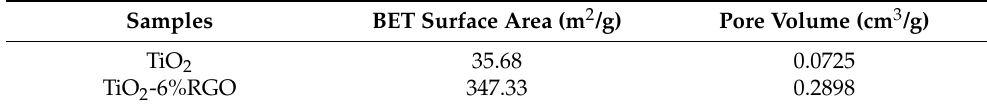
Figure 6. Degradation results of methyl orange at different pH values ( a ) and its first-order kinetic analysis ( b ). Since methyl orange is an anionic dye, when the reaction system is acidic, the en- riched H + in the system makes the catalyst surface positively charged, which is more conducive to the adsorption of dye molecules. When the reaction system is alkaline, the enriched OH - in the system inhibits the adsorption of dye molecules by the catalyst, which is not conducive to the photocatalytic degradation of methyl orange. Interestingly, the photocatalytic performance does not continuously improve with the decrease of pH value of the reaction system, as the degradation performance of pH = 2 is smaller than